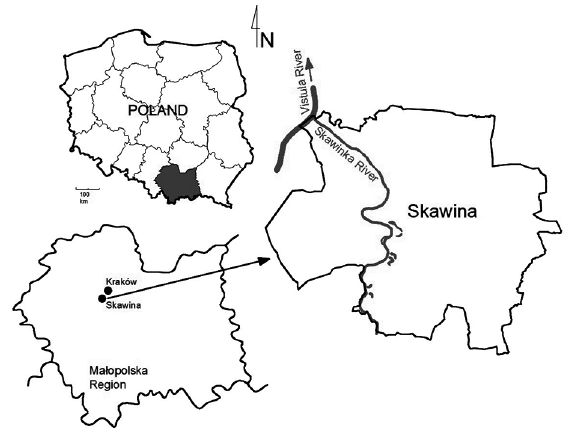
Figure 1. The study area against the contour of the country and the region (drawing from the author’s private